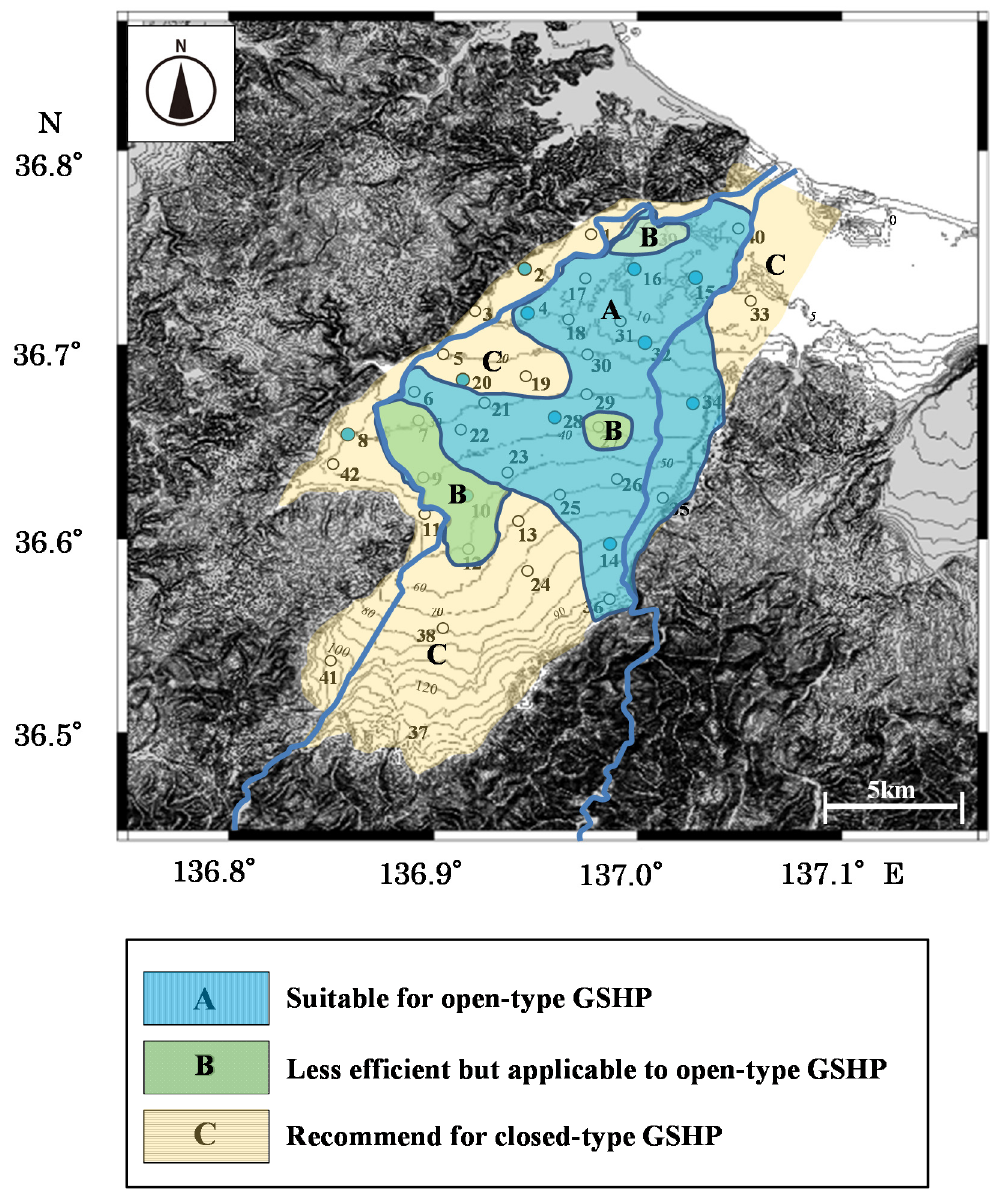
Figure 12. A map showing the study area where open-type ground source heat-pump systems (GSHPs) are recommended. Region A—suitable for open-type GSHP; Region B—less efficient to applicable to open-type GSHP; Region C—recommend for closed-type GSHP.